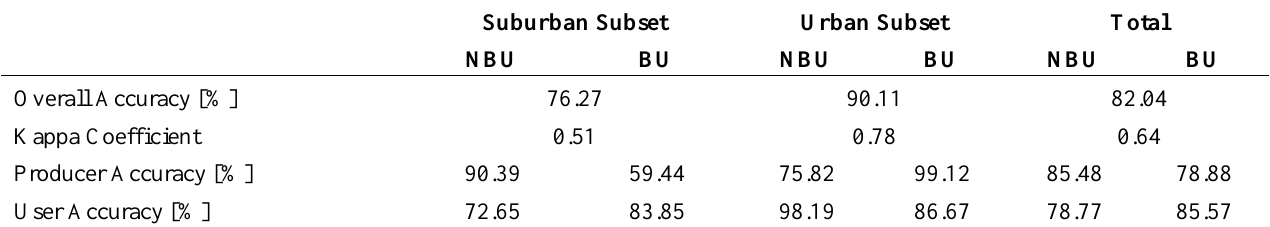
Table 2. Validation results for the suburban and urban subset and overall for built-up (BU) and non-built-up (NBU) urban classes, extracted from the Quickbird imagery of